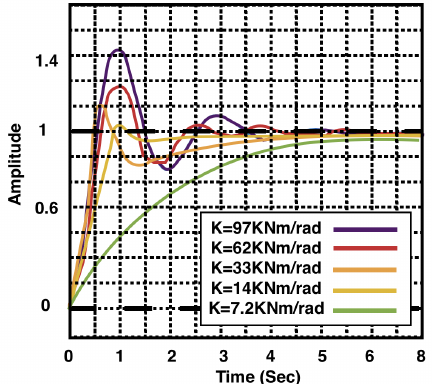
Figure 9. Step response of the output link trajectory for different stiffness values: K= 97,000 Nm/rad, 62,000 Nm/rad, 33,000 Nm/rad , 14,000 Nm/rad and 7200